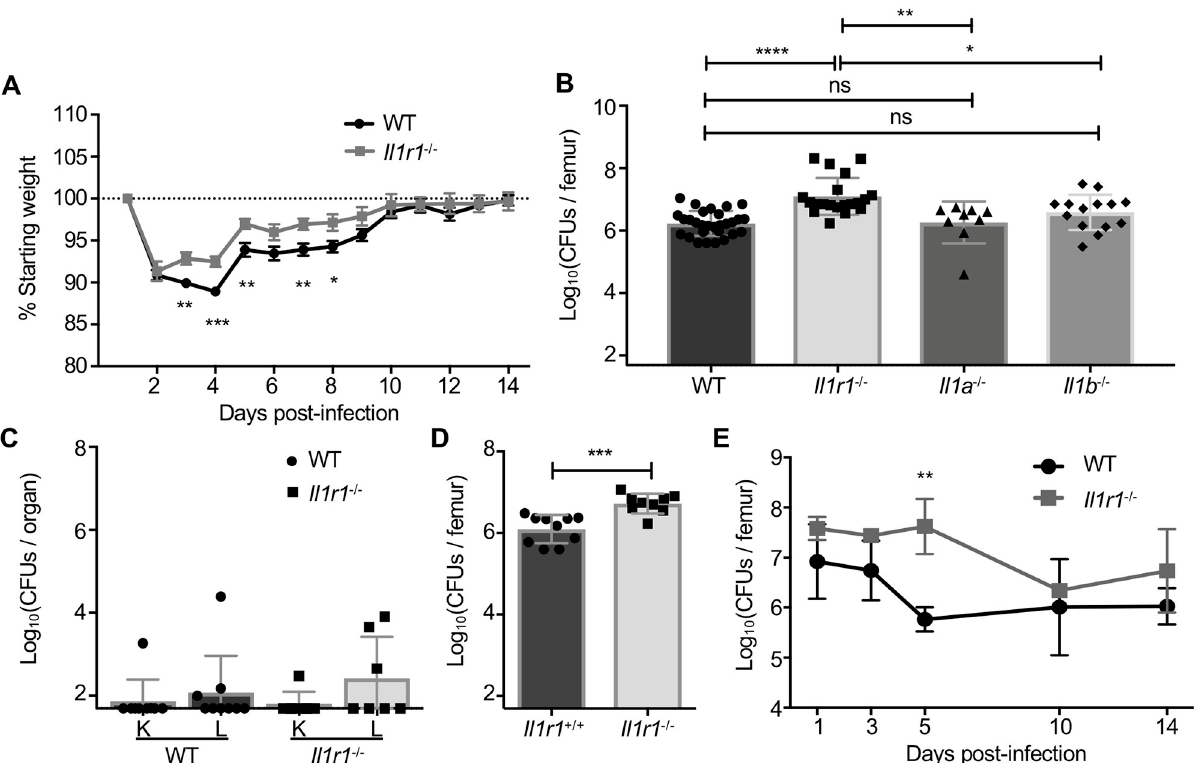
Fig 4. IL-1R signaling contributes to antibacterial immunity in bone. (A) Percent starting weight was monitored daily in triplicate experiments with 10 6 S. aureus CFU infection of female WT and Il1r1 -/- mice (WT n = 15, Il1r1 -/- n = 13). (B-C) At day 14 post-infection with 10 6 S. aureus CFU, bacterial burdens were enumerated from the infected femurs (WT n = 29, Il1r1 -/- n = 20, Il1a -/- n = 9, Il1b -/- n = 14; six independent experiments) (B) or kidneys (K) and liver (L) (WT n = 9, Il1r1 -/- n = 7; duplicate experiments) (C) of each mouse. (D) A subsequent experiment with a 10 6 S. aureus CFU inoculum was conducted in Il1r1 +/+ and ll1r1 -/- mice bred as littermates from a heterozygous colony ( Il1r1 +/+ n = 10, ll1r1 -/- n = 9; duplicate experiments). (E) Following a lower 10 5 S. aureus CFU inoculum, bacterial burdens were enumerated from infected femurs of WT and Il1r1 -/- mice on days 1, 3, 5, 10, and 14 post-infection ( n = 3 mice per genotype per time point). On bar graphs, symbols represent individual data points from a single mouse (WT and Il1r1 +/+ = circles; Il1r1 -/- = squares; Il1a -/- = triangles, Il1b -/- = diamonds) and the mean is represented by the top line of the bar. On timecourse graphs, symbols represent the mean. On all graphs, error bars represent the standard deviation. Unpaired t -tests compared weight recovery and CFU burdens between WT and Il1r1 -/- mice and between Il1r1 +/+ and Il1r1 -/- femurs. A one-way ANOVA with Tukey’s multiple comparisons test was used to compare bacterial burdens harvested from femurs between mice of all genotypes. For kidney and liver burdens, separate t -tests compared WT and Il1r1 -/- burdens from each organ site. � p < 0.05, �� p < 0.01, ��� p < 0.001, ���� p < 0.0001, ns = not significant.